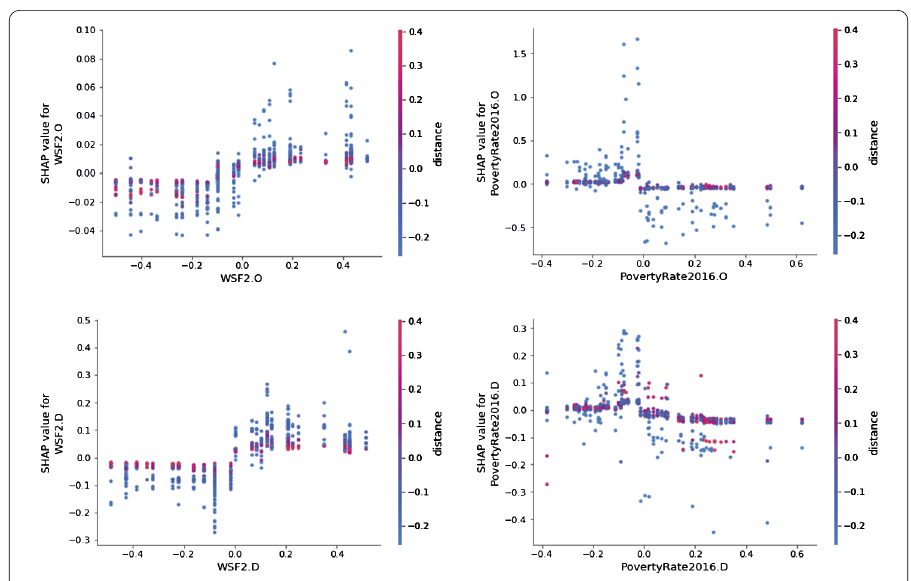
Figure 10 SHAP values of features with the interaction of